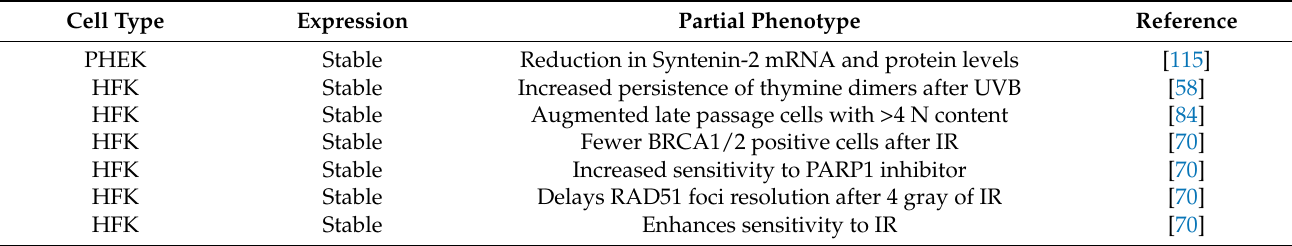
Figure 2. Phylogenetic tree of β -HPV and MmuPV1 based on the E6 nucleotide sequence (https://pave.niaid.nih.gov/, accessed on 14 May 2021). E6s with identical amino acid sequence highlighted to match corresponding E6s either known to bind p300 (HPV8, 5, 20, 25, 38) or not bind p300 (MmuPv1). Table 1. Phenotypes of HPV8 E6 ∆ 132-136 that are weaker than those of wild type HPV8 E6. Cell lines abbreviations: primary human epidermal keratinocytes (PHEK), human foreskin keratinocyte (HFK). Stable expression via lentiviral